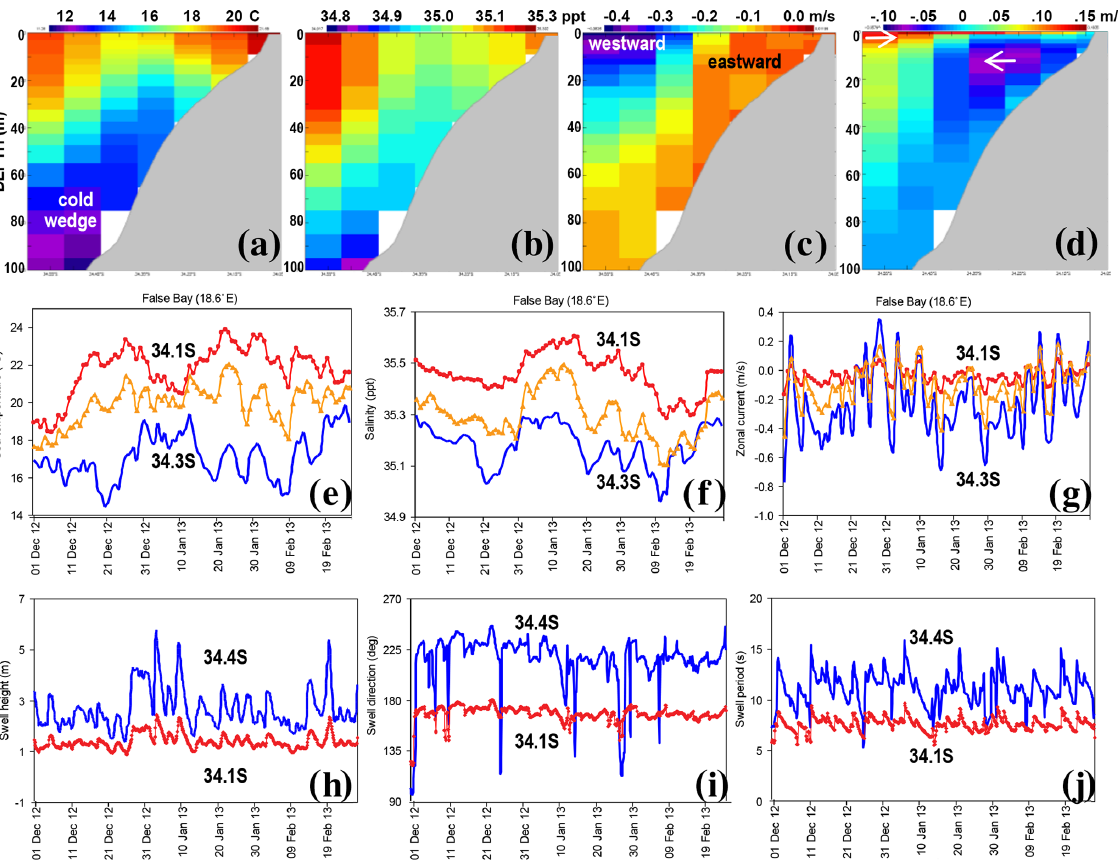
Figure 4. HYCOM mean summer December 2012–February 2013 depth section along 18.6 ◦ E: (a) temperature, (b) salinity, (c) zonal current and (d) meridional current, with shelf profile. (e–g) Surface layer T , S and U time series at points 1–3. Ocean wave time series December 2012–February 2013 from W3 data at points 1 and 4: (h) swell height, (i) swell direction and (j) swell period. Shelf edge is plotted – blue, mid-bay – orange, coastal –